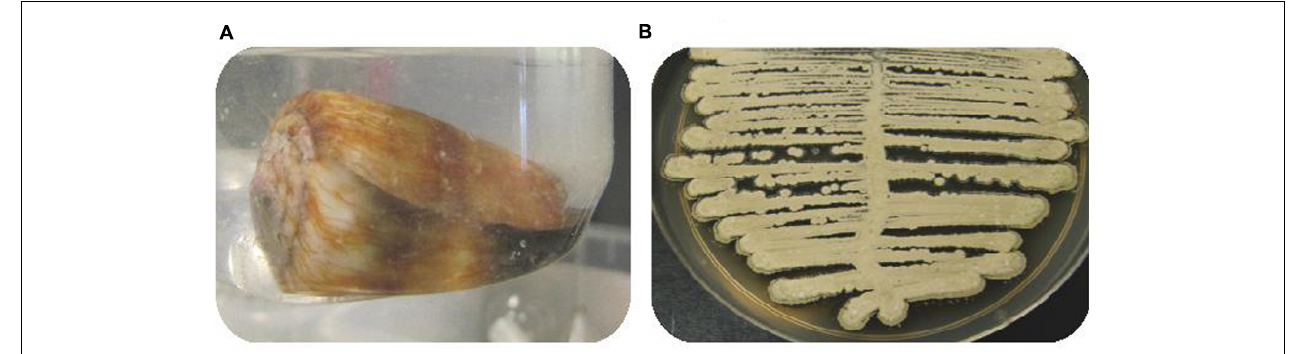
FIGURE 1 | (A) Image of cone snail C. miles (B) ISP-4 agar plate cultivation displaying the common phenotype of Streptomyces sp. after 10 days incubation at 26.5 ◦ C.